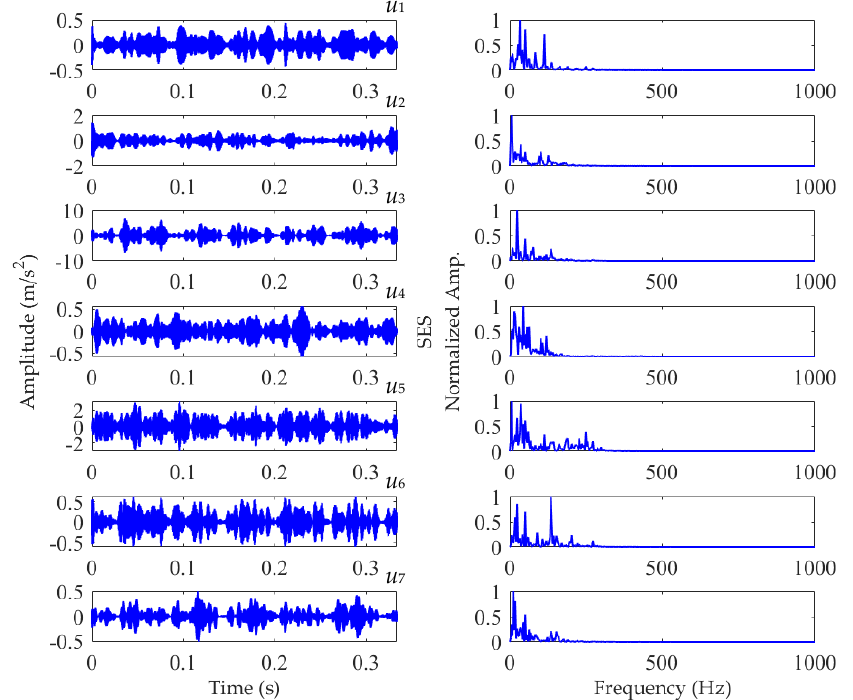
the target mode at each step of α increase.